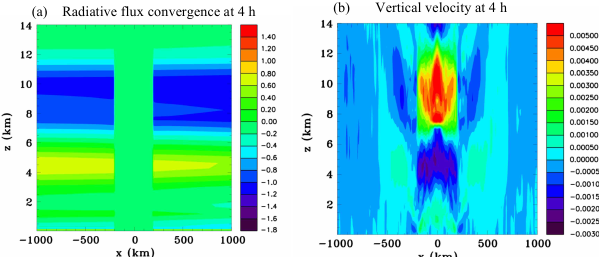
Figure 17. Vertical sections for Experiment 12: the radiation scheme activated in the environment, r > 200km. (a) Radiative flux convergence (Ks − 1 × 10 − 5 ), and (b) vertical velocity (ms − 1 ), at t = 4h.